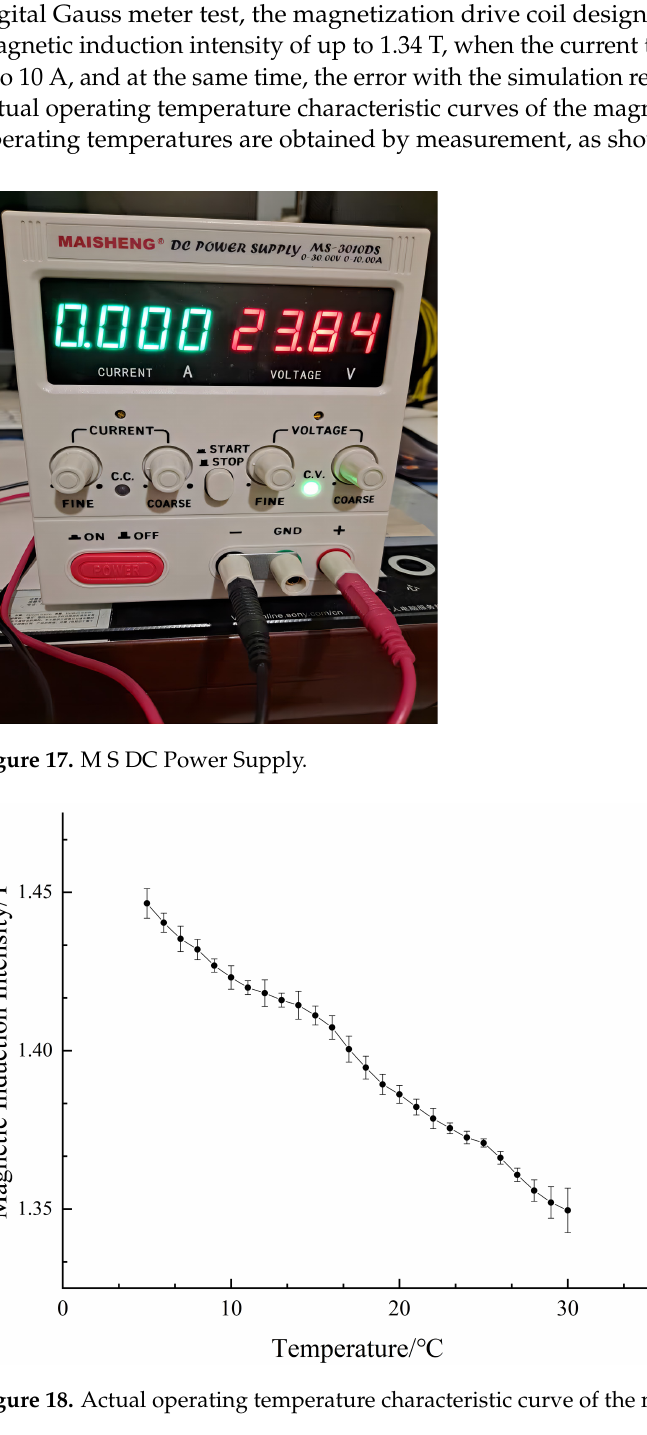
Figure 19. Comparison of the simulated and measured temperature characteristic curves. 4. Conclusions In this paper, based on the principle of the Helmholtz coil, a new type of magnetiza- tion drive coil is obtained by adding a pair of auxiliary coils on both sides of the coil to compensate for the field strength at the center point of the Helmholtz coil and away from the center point. This magnetization drive coil has a small size, high central magnetic in- duction strength, dense magnetic induction distribution, and low fabrication cost. First, we simulate the magnetization drive coil model by using the finite element analysis software Maxwell and select the circular Helmholtz coil with a large central mag- netic induction as the unit coil of the magnetization drive coil. Then, we build a three- dimensional model, analyze the influence of the distance between the two auxiliary coils on their central magnetic induction, and select the optimal auxiliary coil distance. We change the number of turns to analyze its influence on the central magnetic induction of the Helmholtz coil and the magnetization drive coil. Finally, we compare the optimized